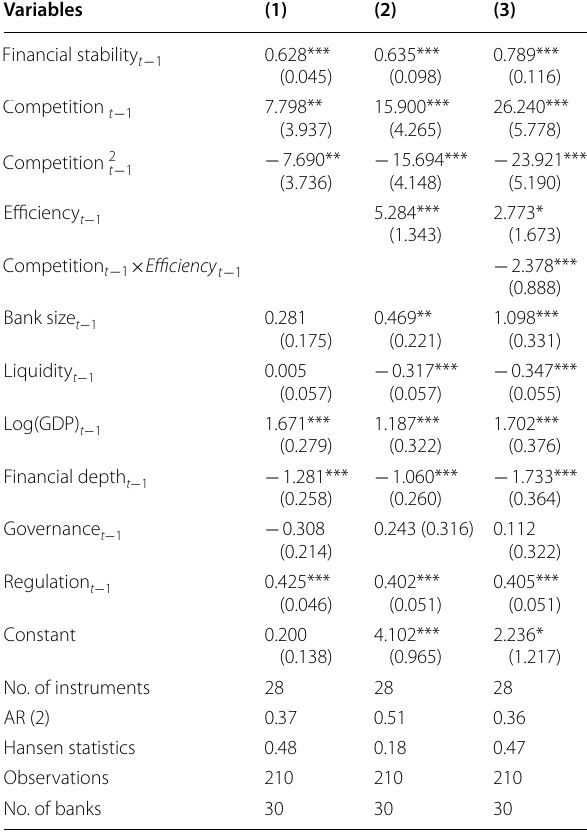
Table 5 Robustness check using alternative control